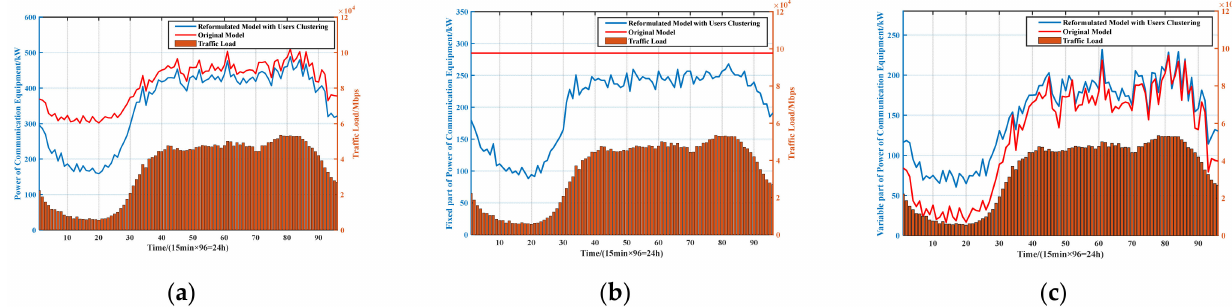
Figure 10. ( a ) Total power of communication equipment, ( b ) fixed part of the power of communication equipment, and ( c ) variable part of the power of communication